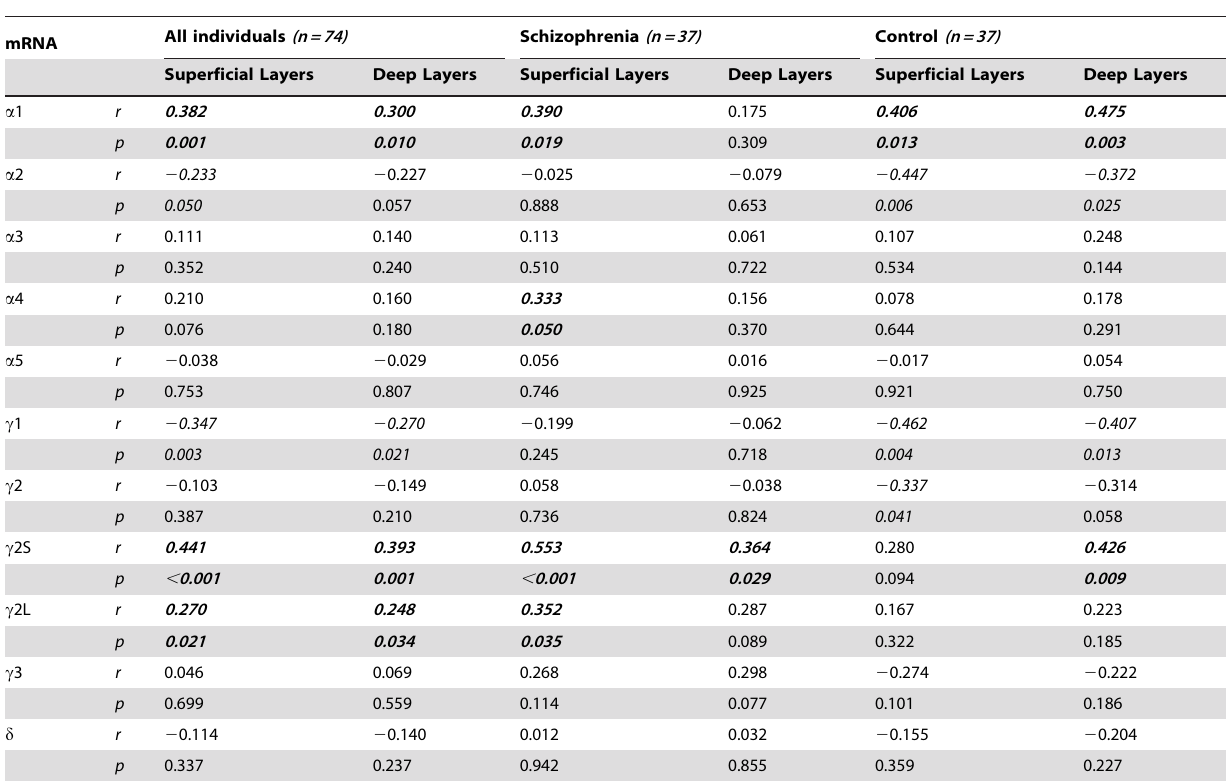
Table 3. Correlations between [ 3 H]Flumazenil binding and a - c / d GABA A R subunit mRNAs.